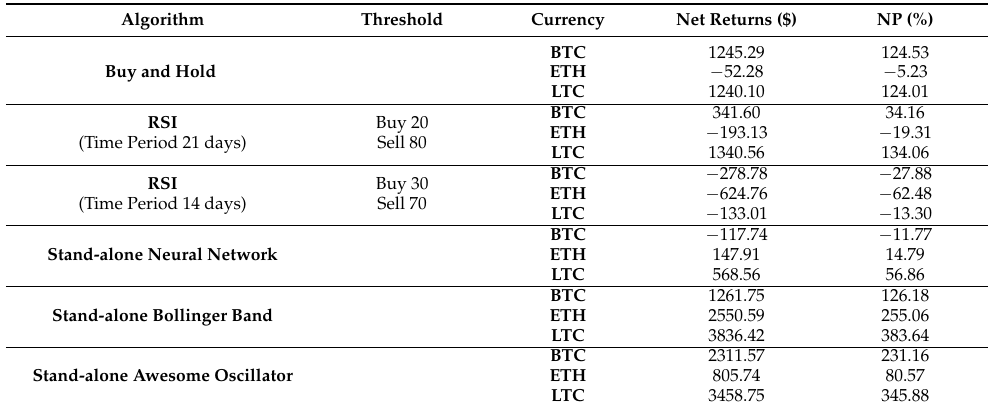
Table 4. Returns on stand-alone